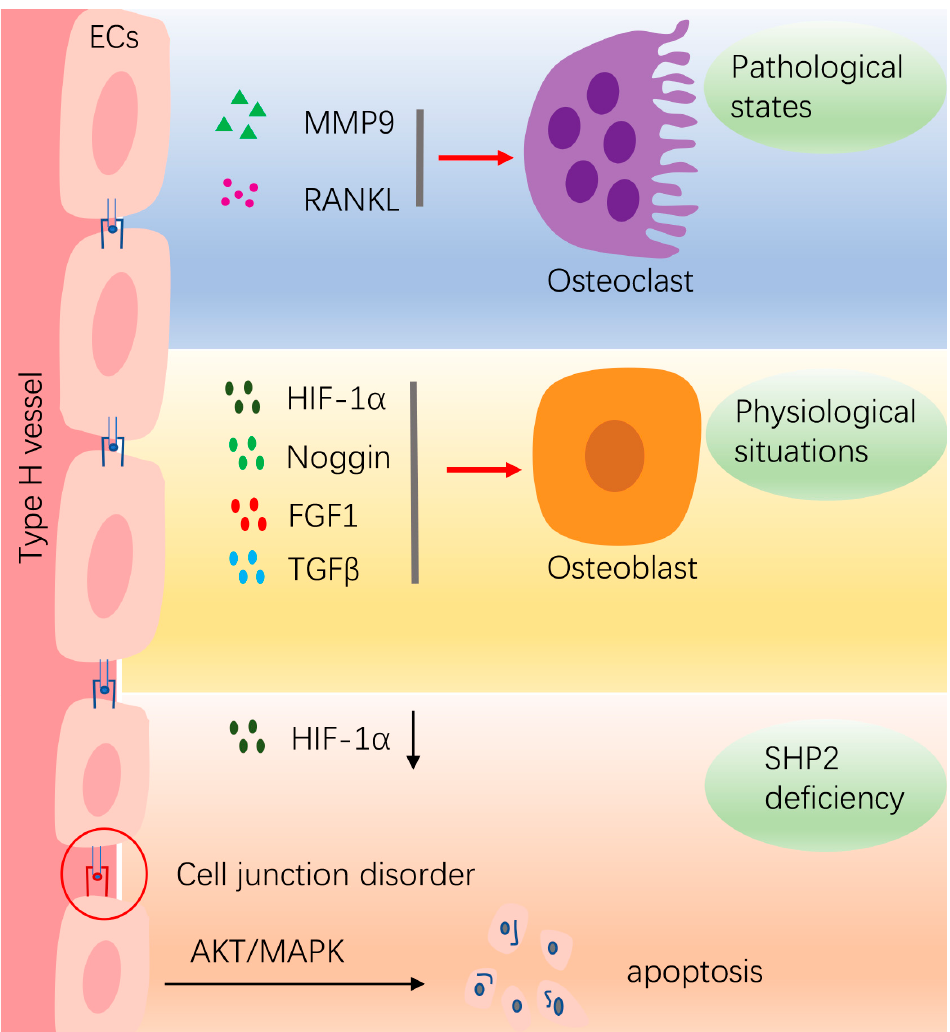
Figure 2. The effects of SHP2 on bone homeostasis by affecting vasculature ECs. In physiological situations, ECs release multiple cytokines, such as HIF-1 α , Noggin, FGF1, TGF β , etc., to promote osteogenesis. In pathological conditions, such as in inflammatory conditions, ECs secrete MMP9 and RANKL to promote osteoclastogenesis. Deletion of SHP2 in ECs decreases HIF-1 α expression. Furthermore, the junctions between ECs are disordered and the integrity of the vascular barrier is disrupted. The SHP2-deficient ECs undergo apoptosis through activation of MAPK and AKT pathways. “Red arrow” refers to promotion.